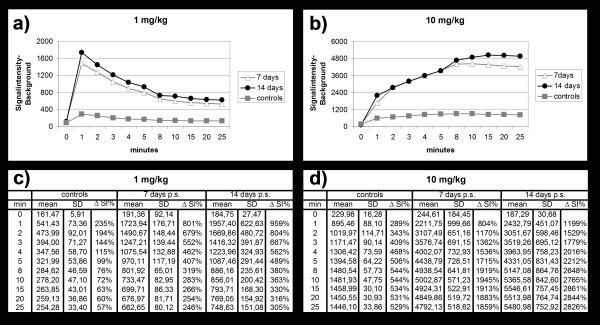
Mean fluorescence signal intensities subtracted from the background signal intensity (a, b) and corresponding quantitative data (c, d) of mean fluorescence signal intensities, standard deviation (SD) and the relative fluorescence signal enhancement (ΔSI%) of the paravertebral soft tissue in the area of previous surgery of the experimental group compared to the controls as measured before and continuously 1–25 min after injection of 1 mg/kg (a, c) and 10 mg/kg (b, d) ICG.